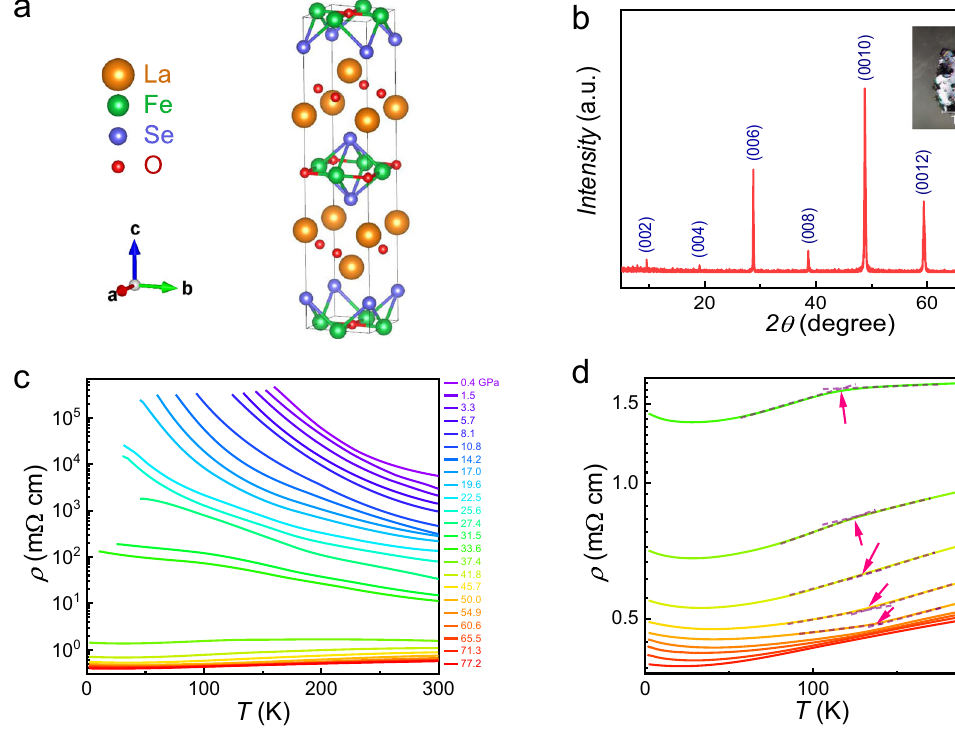
Fig.1|Structuralandhigh-pressuretransportpropertiesofLa 2 O 3 Fe 2 Se 2 .a The La 2 O 3 Fe 2 Se 2 crystal structure. b X-ray diffraction pattern of La 2 O 3 Fe 2 Se 2 single crystalwiththecorrespondingMillerindices(00l)inparentheses.Theinsetshows photo of a typical La 2 O 3 Fe 2 Se 2 single crystal. c Temperature dependence of resis- tivity in La 2 O 3 Fe 2 Se 2 single crystal under high pressure. An insulator-metal